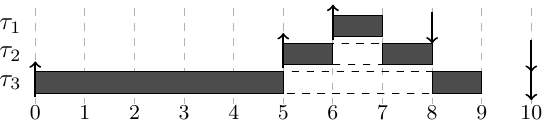
Figure 3 Example schedule showing how the scheduler chooses which task should execute. Task τ 3 is released at t = 0. At t = 5, task τ 2 is released, pre-empting τ 3 as although it has the same absolute deadline, it has a lower task index. At t = 6, task τ 1 is released, pre-empting task τ 2 . At t = 7, τ 1 completes, the scheduler then chooses to resume task τ 2 as although it has the same absolute deadline as task τ 3 , it has the lower task